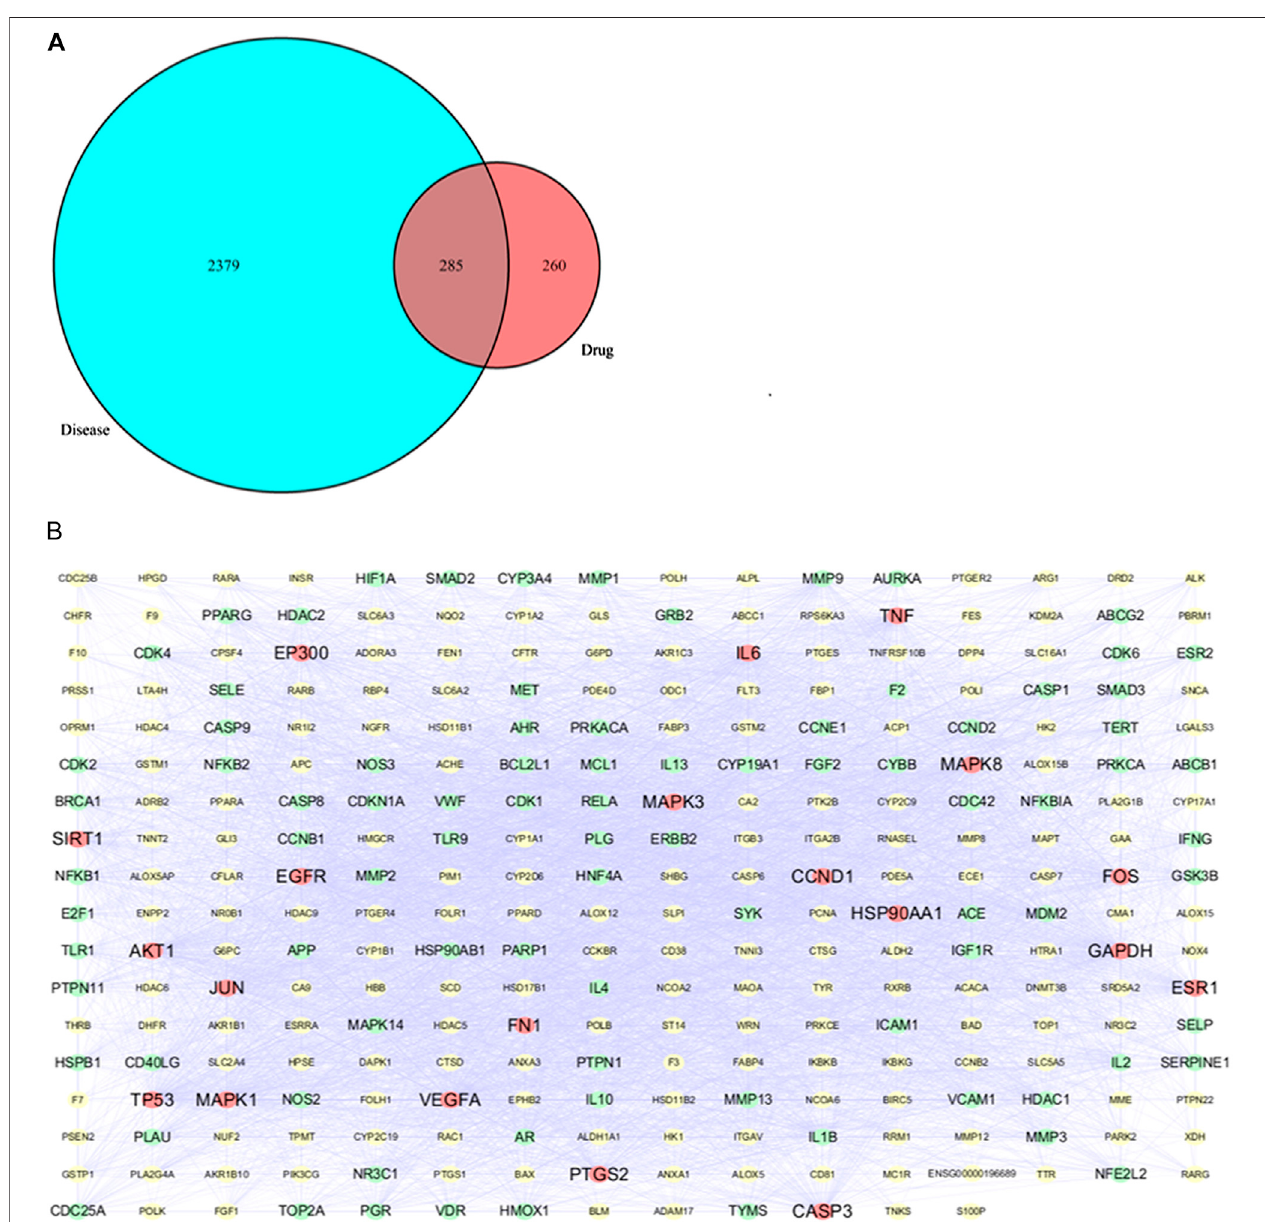
FIGURE 8 | (A) Venny diagram of related targets of drug and disease (B) PPI network of 285 overlapping targets between drug and disease.